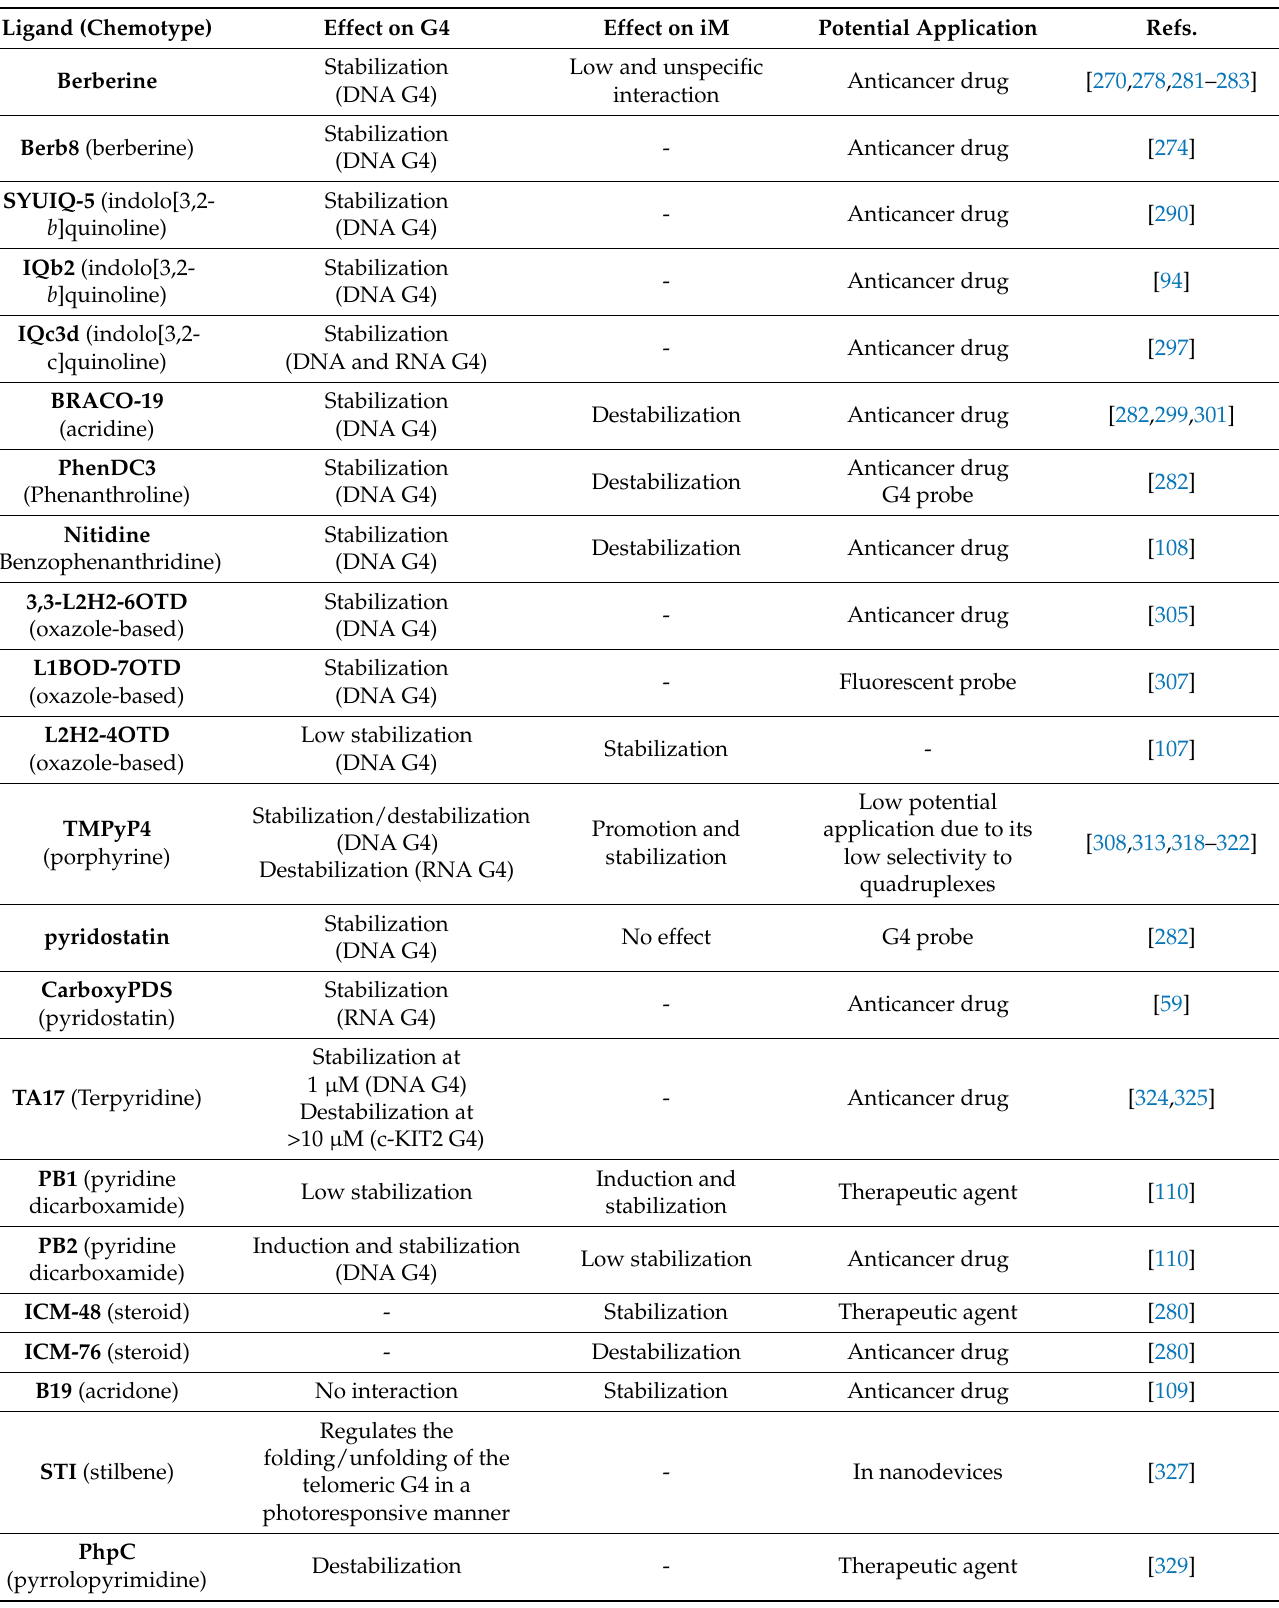
Table 6. Effects of selected G4 ligands on G4s and iMs, and their potential